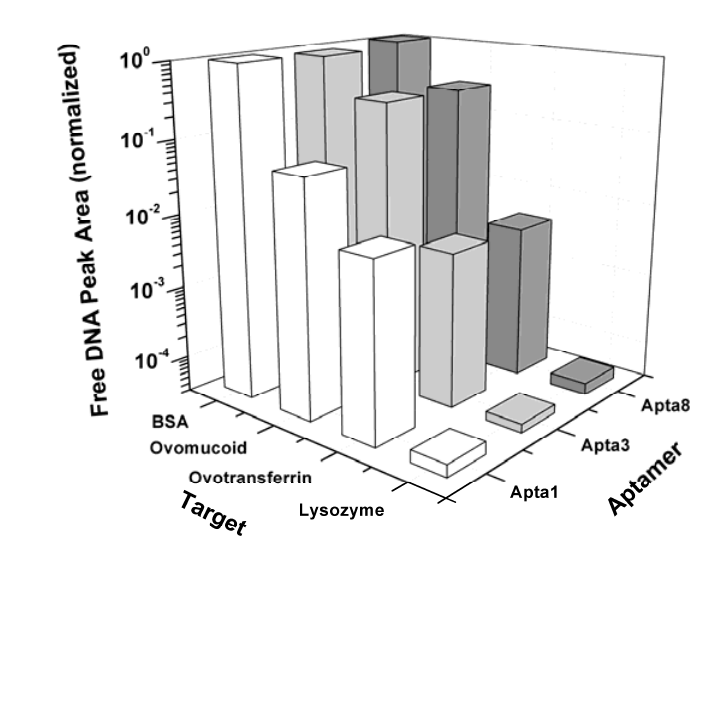
Figure 6. Specificity of the selected aptamers Apta1, Apta3 and Apta8 for lysozyme and for ovomucoid, ovotransferrin and BSA measured with affinity capillary